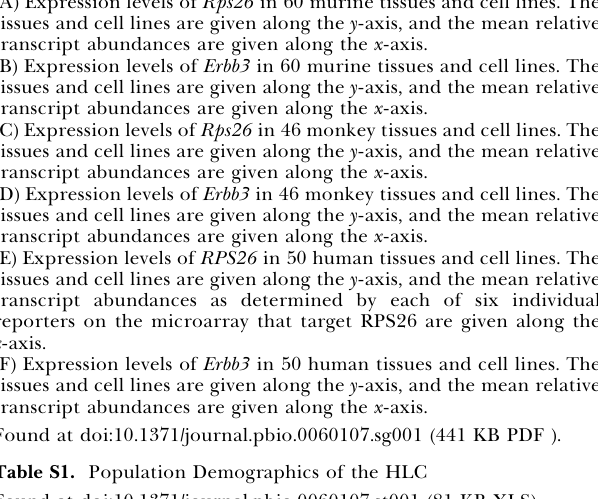
Figure S1. Atlas of Gene Expression for Rps26 and Erbb3 For all panels, the horizontal bar for each row represents the mean expression value and the horizontal line indicating the standard deviation. The red arrow off to the left highlights the pancreas tissue. (A) Expression levels of Rps26 in 60 murine tissues and cell lines. The tissues and cell lines are given along the y -axis, and the mean relative transcript abundances are given along the x -axis. (B) Expression levels of Erbb3 in 60 murine tissues and cell lines. The tissues and cell lines are given along the y -axis, and the mean relative transcript abundances are given along the x -axis. (C) Expression levels of Rps26 in 46 monkey tissues and cell lines. The tissues and cell lines are given along the y -axis, and the mean relative transcript abundances are given along the x -axis. (D) Expression levels of Erbb3 in 46 monkey tissues and cell lines. The tissues and cell lines are given along the y -axis, and the mean relative transcript abundances are given along the x -axis. (E) Expression levels of RPS26 in 50 human tissues and cell lines. The tissues and cell lines are given along the y -axis, and the mean relative transcript abundances as determined by each of six individual reporters on the microarray that target RPS26 are given along the x -axis. (F) Expression levels of Erbb3 in 50 human tissues and cell lines. The tissues and cell lines are given along the y -axis, and the mean relative transcript abundances are given along the x -axis. Table S1. Population Demographics of the HLC Table S2. Association Results for HLC Expression and Genotyping Data Table S3. Expression Traits Corresponding to Genes Associated with Human Diseases Are under Significant Genetic Control in the HLC Table S4. Genes Represented on the HLC Microarray Described in the Main Text Table S5.